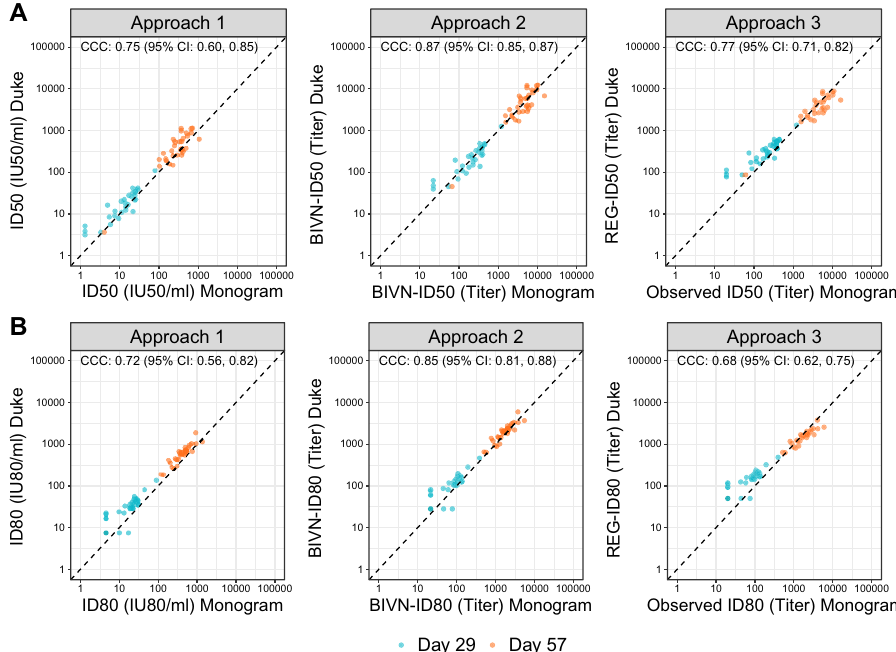
Figure 3. Scatterplots of calibrated ID50 (Panel A ) and ID80 (Panel B ) titers from the Duke and Monogram labs demonstrating performance of the three calibration approaches using vaccine recipient samples collected at Day 29 (turquoise) and Day 57 (orange), 4 weeks post the first and the second mRNA-1273 vaccine doses, respectively. The arithmetic mean-based calibration factor was used in Approach 1. The concordance correlation coefficient (CCC) and 95% confidence intervals indicate the level of agreement between the x- and y-axis values. ID50, ID80: ID50, ID80 titers calibrated to the WHO International Standard, expressed in International Units per ml (IU50/ml for ID50; IU80/ml for ID80) (Approach 1). BIVN-ID50, BIVN-ID80: ID50, ID80 titers from each lab calibrated to a common scale using an independent pool of clinical samples, assuming a bivariate normal distribution for the readouts from the two labs (Approach 2). REG-ID50, REG-ID80: ID50, ID80 titers from the non-reference lab (Duke) calibrated to the reference lab (Monogram) using an independent pool